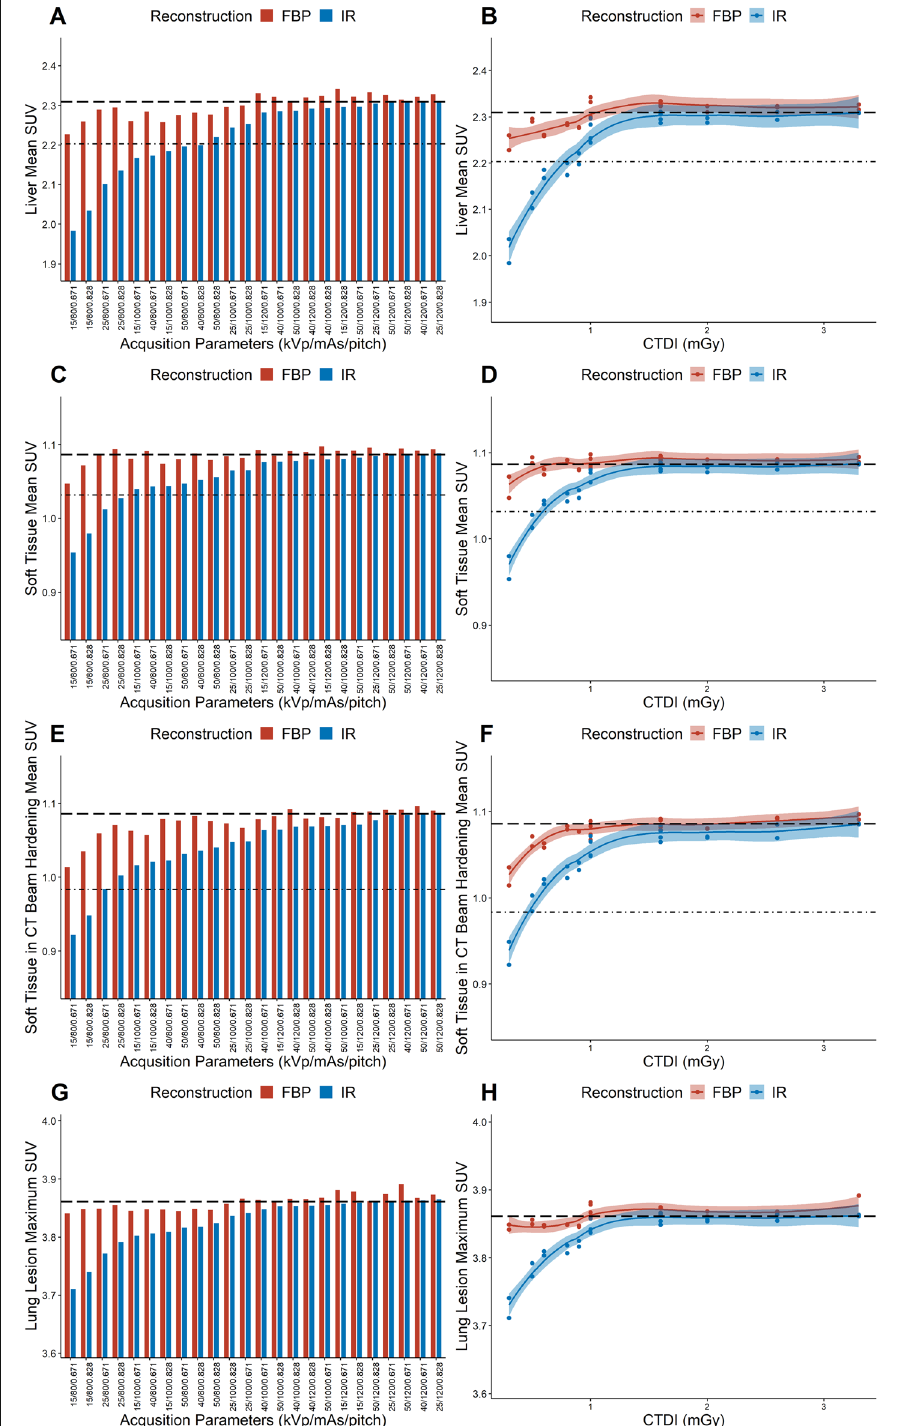
Fig. 2 Mean SUV of liver ( a ), soft tissue ( c ), soft tissue in beam hardening region ( e ) and maximum SUV of the lung lesion ( g ) for each TR. The values from the RR are indicated by the dashed black line, and 1 standard deviation below the mean of the RR SUV is indicated by the dot dash black line (not applicable for the maximum SUV of the lung lesion). Mean SUV of liver ( b ), soft tissue ( d ), soft tissue in beam hardening region (f) and maximum SUV of the lung lesion ( h ) for each CT test reconstruction relative to CTDI. Shaded areas indicate confidence limits based on locally weighted regression fitting